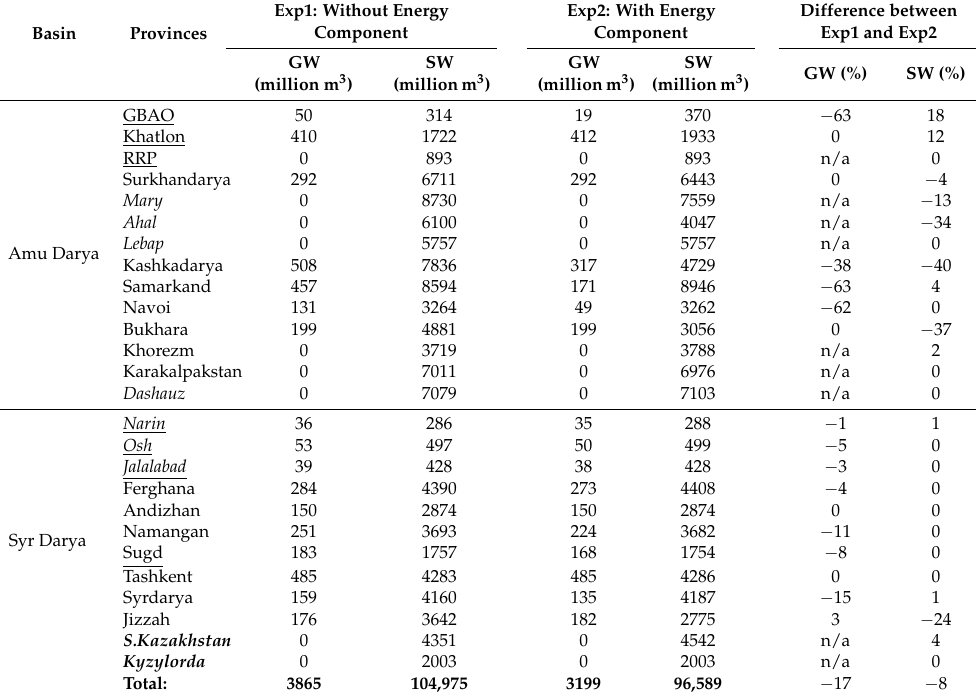
Narin 36 286 288 Syr Darya